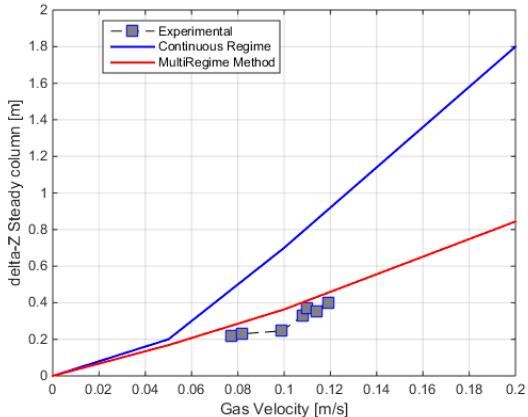
Figure 11. Steady water column height. (Red) Multi-regime interaction model, (Blue) continuous regime interaction model.